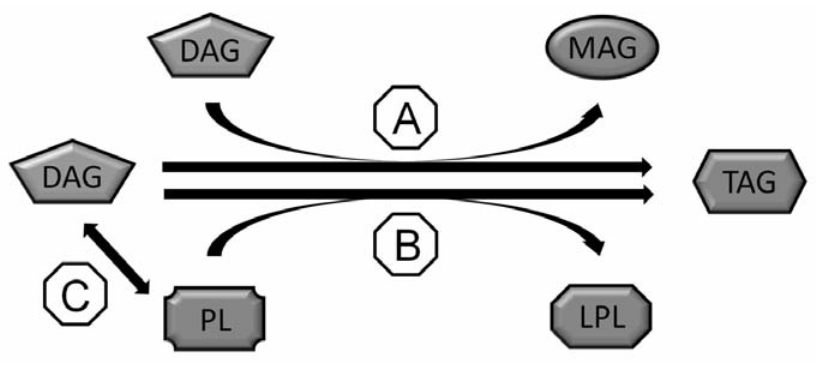
Figure 3. Acyl-CoA independent pathways for triacylglycerol (TAG) biosynthesis. Diacylglycerol transacylase (A) catalyzes the transfer of an acyl moiety between two dia- cylglicerol (DAG) molecules to form TAG and monoacylglycerol (MAG) as a co-product. Phospholipid: diacylglycrol acyltransferase (B) catalyzes the transfer of fatty acids